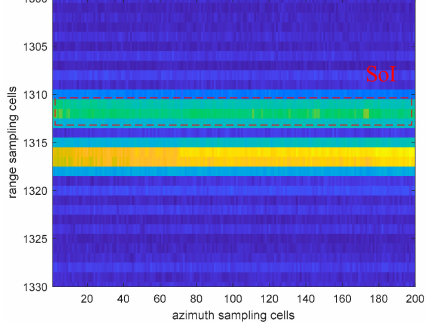
Figure 27. Range compression result of echo.